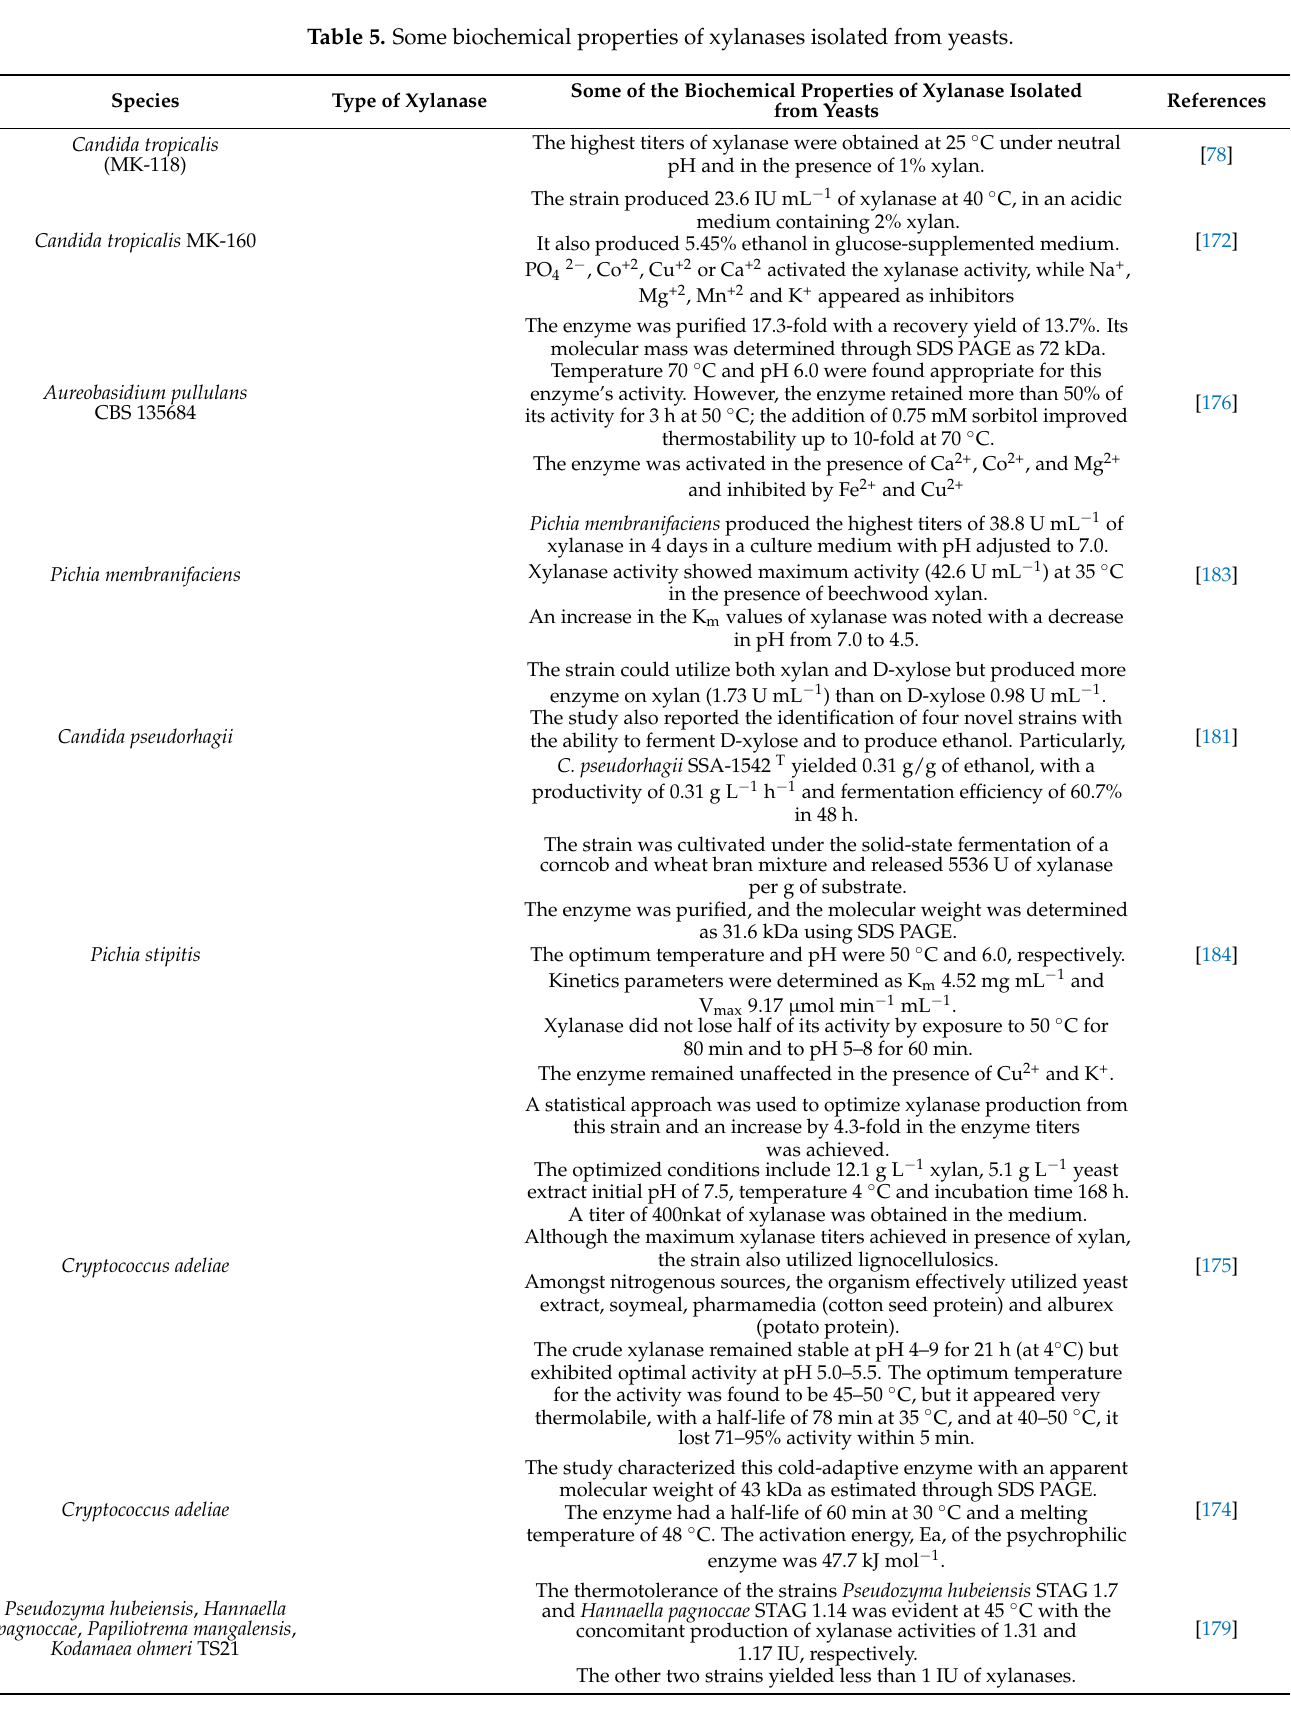
Table 5. Some biochemical properties of xylanases isolated from